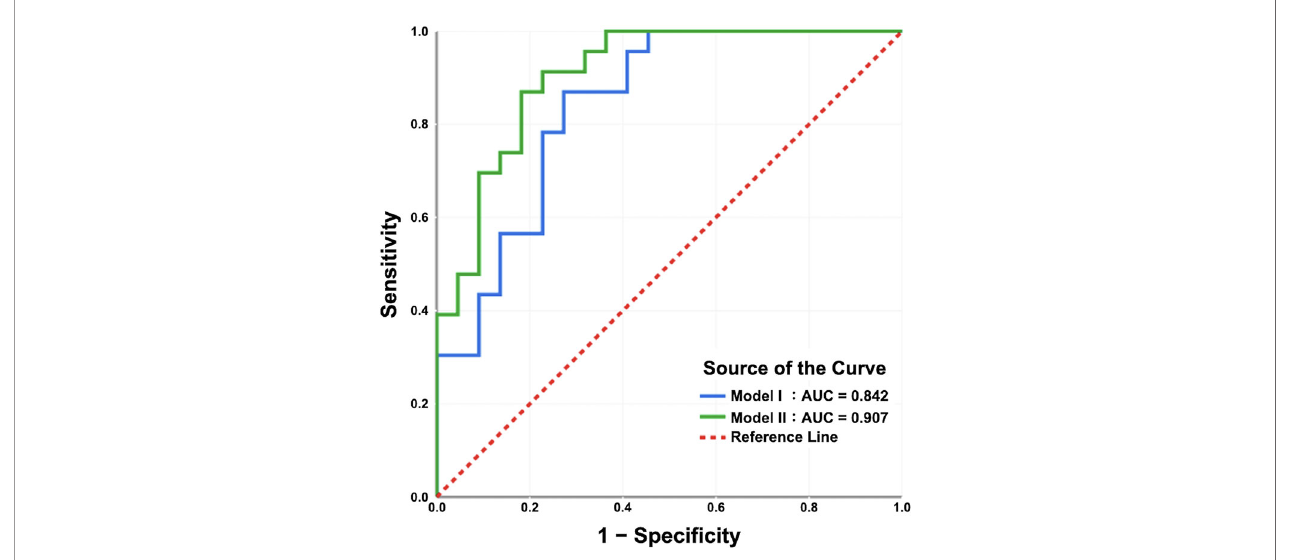
FIGURE 5 | The receiver operating characteristic curves of the prediction models. The areas under the curves of model I and model II are 0.842 and 0.907, respectively. In model I, the IVIM/ADC parameters D mean and D* kurtosis were signi fi cant predictors for the ISUP high-risk group according to radical prostatectomy (RP) specimens. In model II, the use of the preoperative ISUP grade as an adjustment variable, in addition to D mean and D* kurtosis , may enhance the predictive performance of the